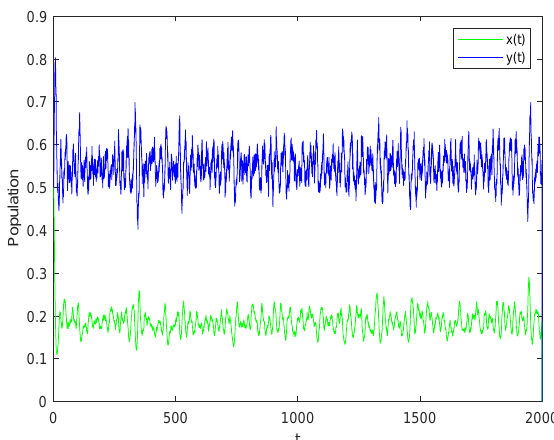
Figure 11. Dynamical behaviors of (3). The parameters are taken as (32) and σ 1 = 0.03, σ 2 =